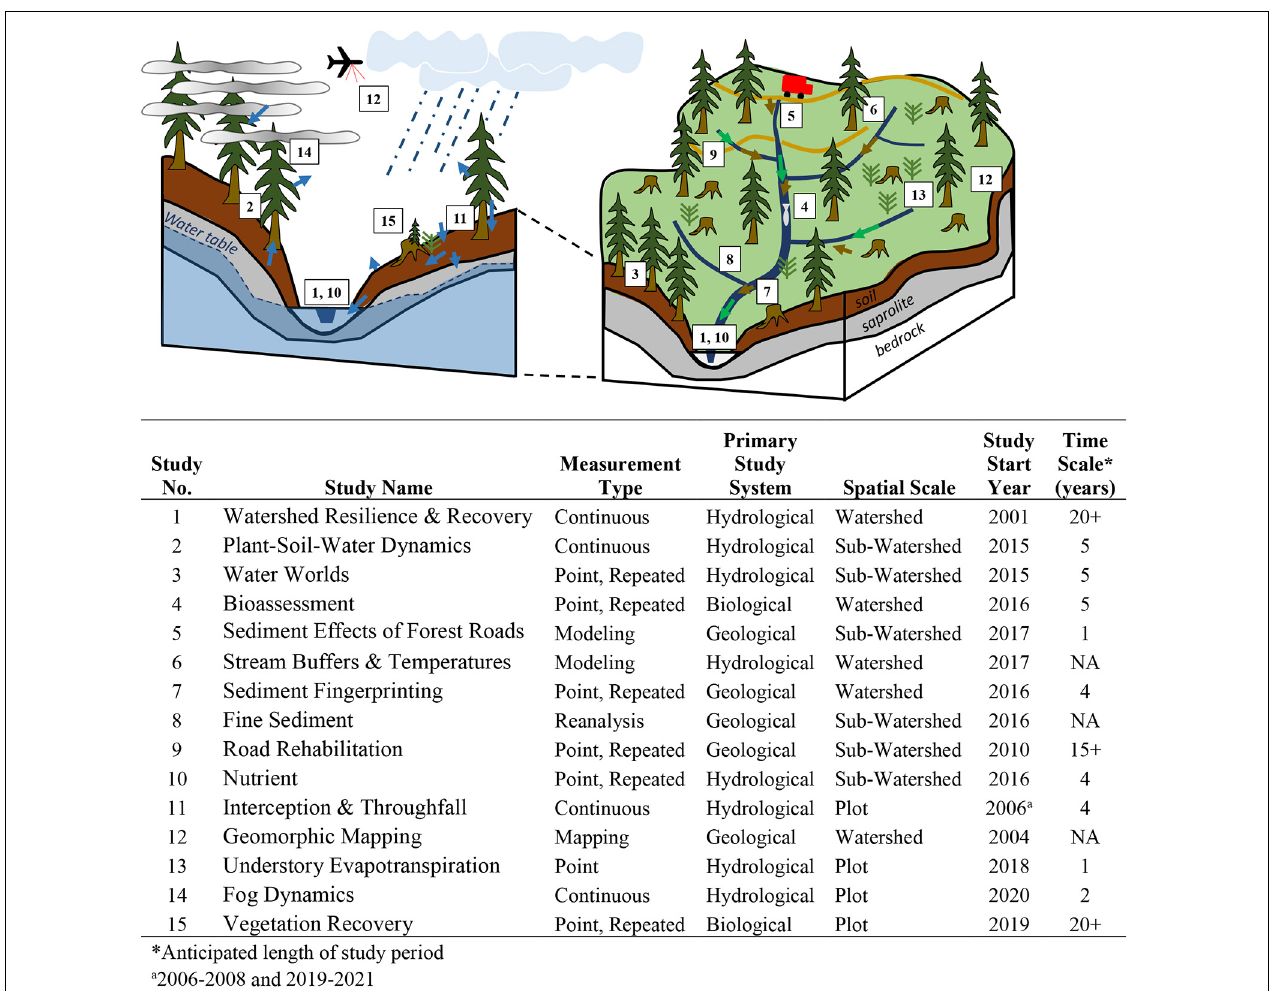
FIGURE 2 | Conceptual study diagram depicting approximate spatial representation of 15 studies associated with the Third Experiment. Study numbers and descriptions are located in the table. Arrows represent the following (not to scale): blue, hydrologic fluxes; green, nutrient fluxes; brown, sediment